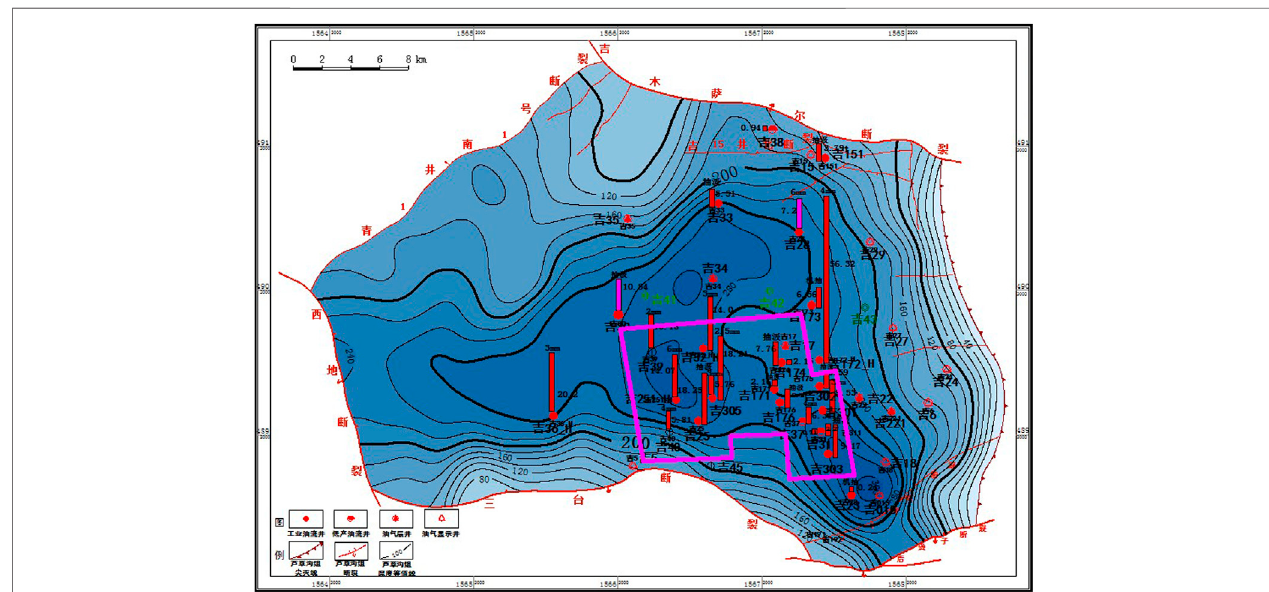
FIGURE 1 | Jimusar shale oil fi